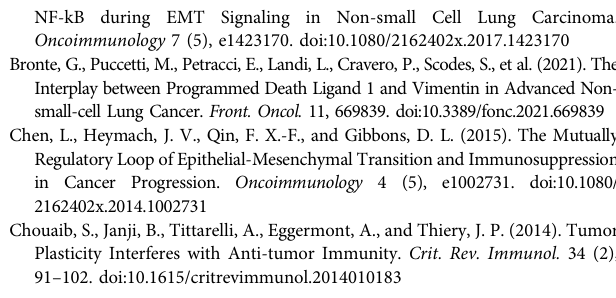
Frontiers in Cell and Developmental Biology |